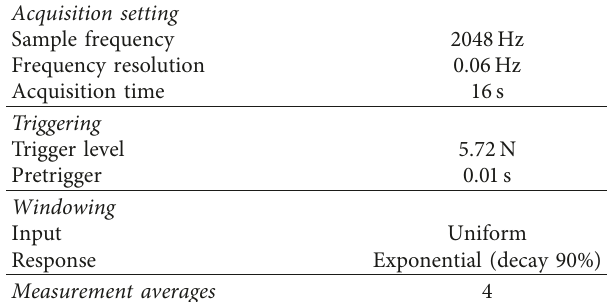
Table 2: Impact test settings.